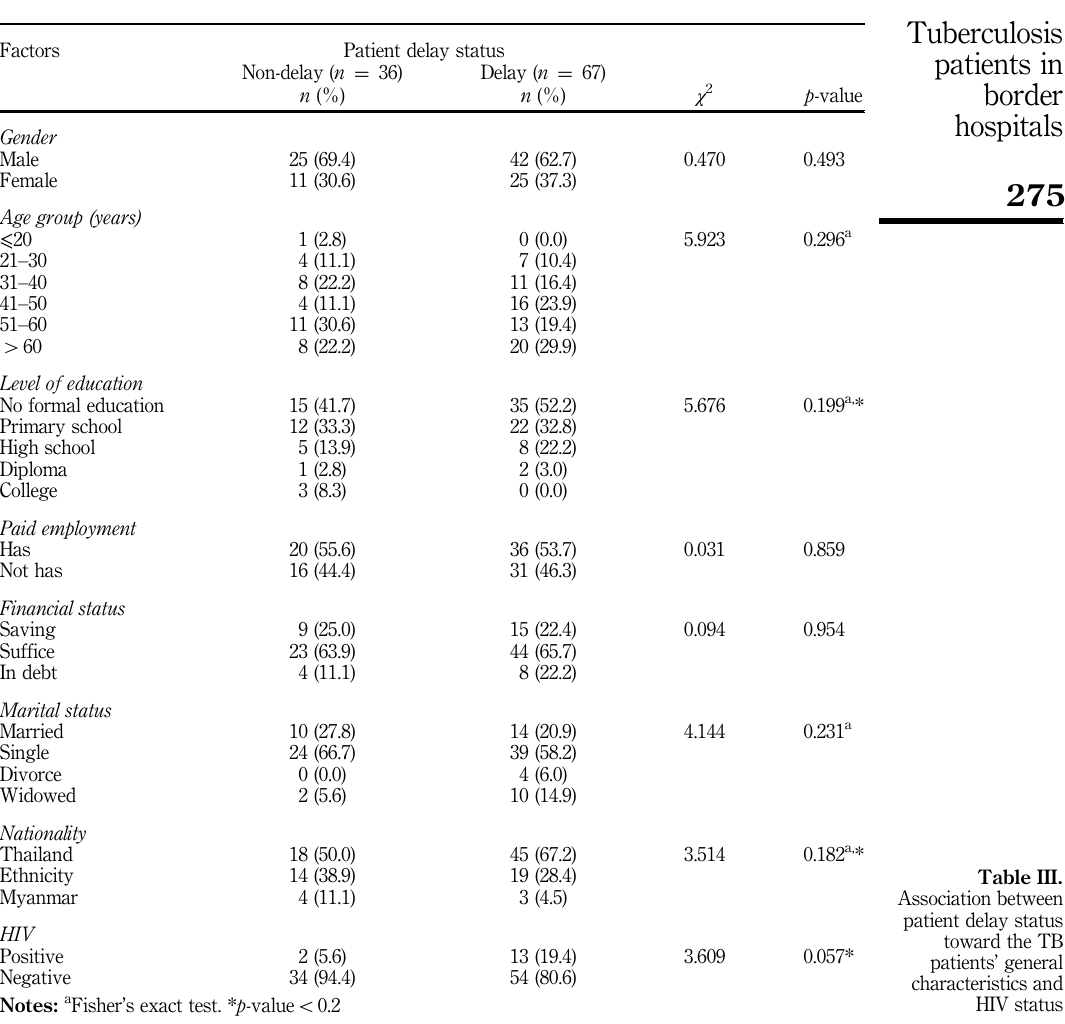
Table III. Association